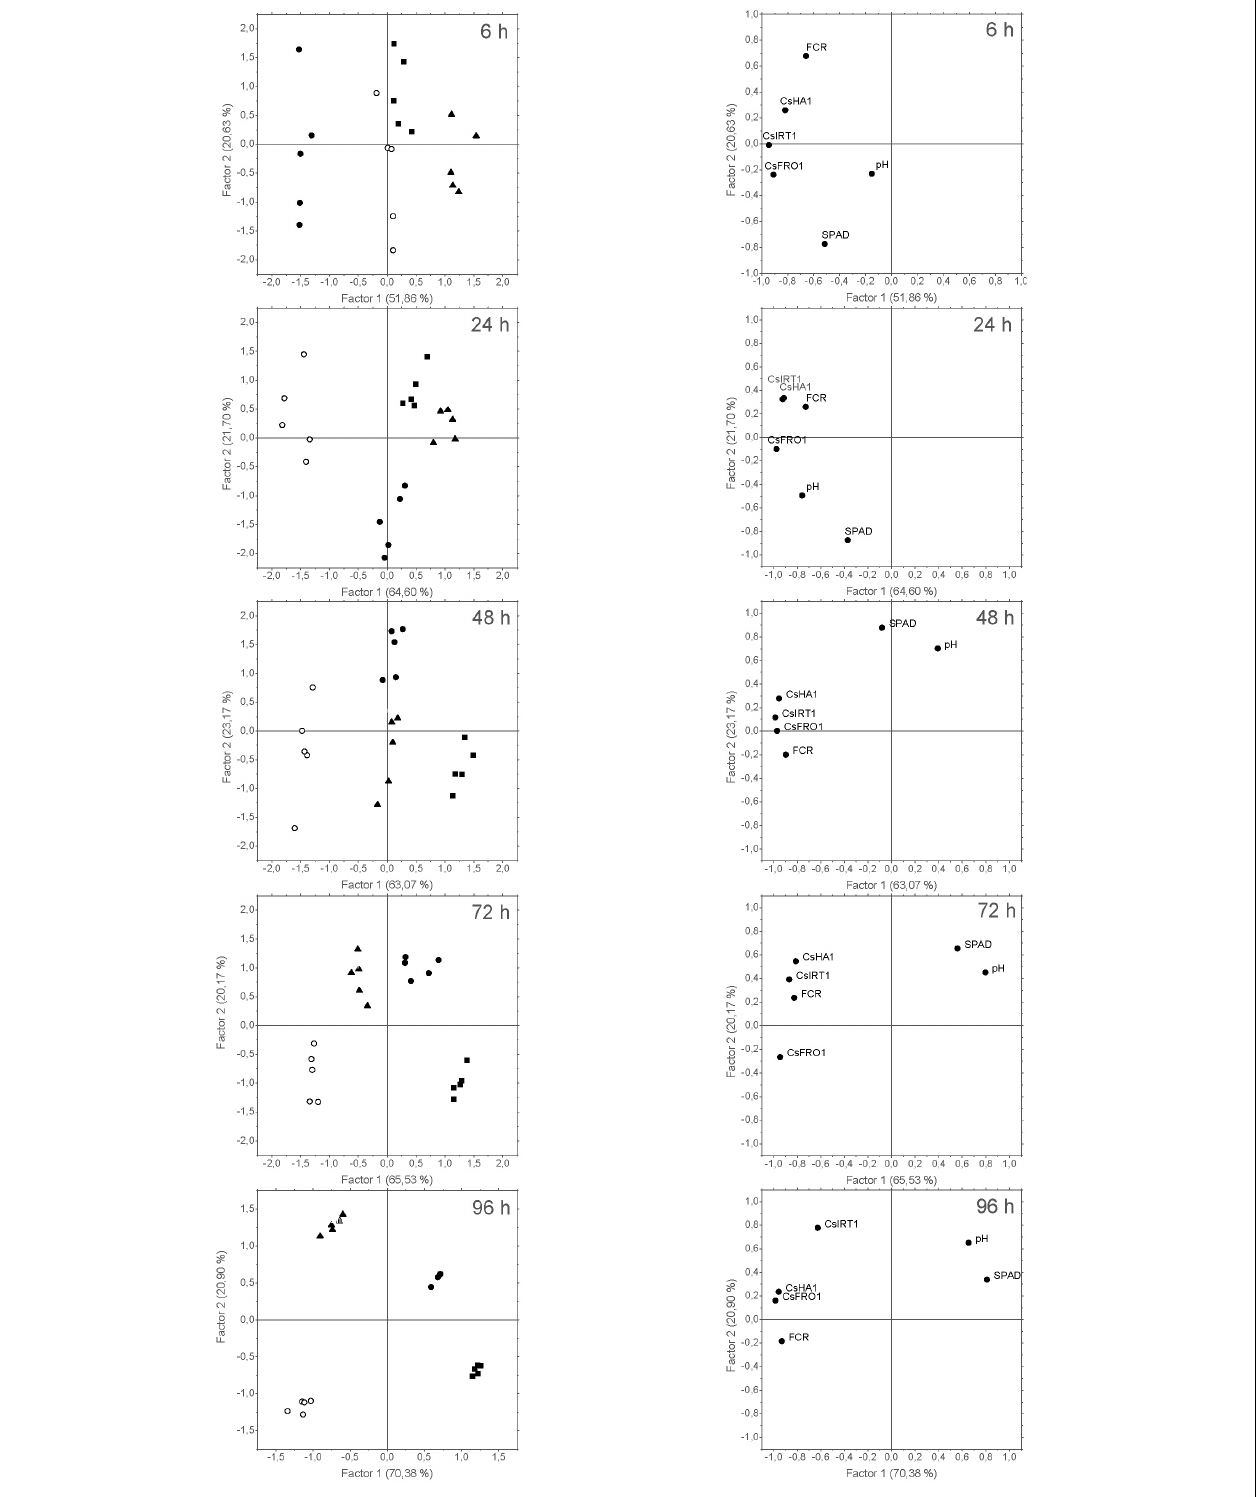
FIGURE 9 | Score plots of the cases (left) and loading plots of the variables (right) from the PCA of data derived from Experiment I. Five cases per treatment were considered: +Fe control ( ), –Fe control ( ), 3 mM FeSO 4 ( (cid:4) ), and 9 mM FeSO 4 ( (cid:78) ). The variables introduced in the analysis were: SPAD values measured in leaves (SPAD); pH values measured in NS (pH); CsFRO1 , CsIRT1, and CsHA1 relative expression results (CsFRO1, CsIRT1, CsHA1); and FCR activity in roots (FCR). The (cid:32) (cid:35) number in brackets is the percentage of total variance explained by the